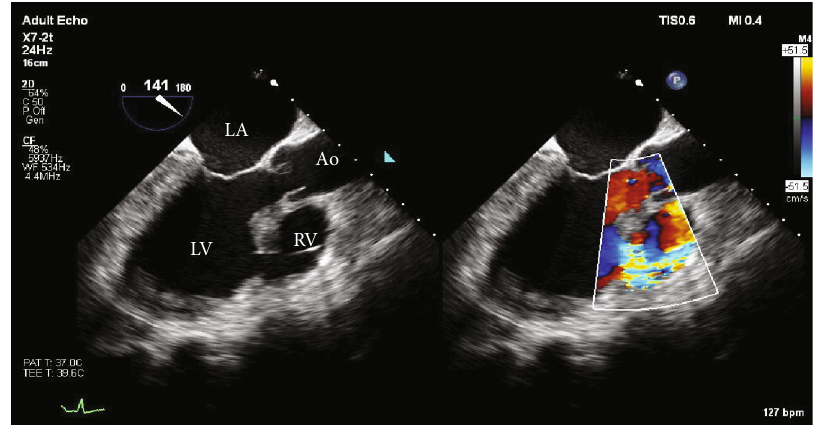
Figure 2: Transesophageal echocardiogram, midesophageal 3-chamber view taken whilst on Impella support, showing large VSD with left- to-right shunting on colour